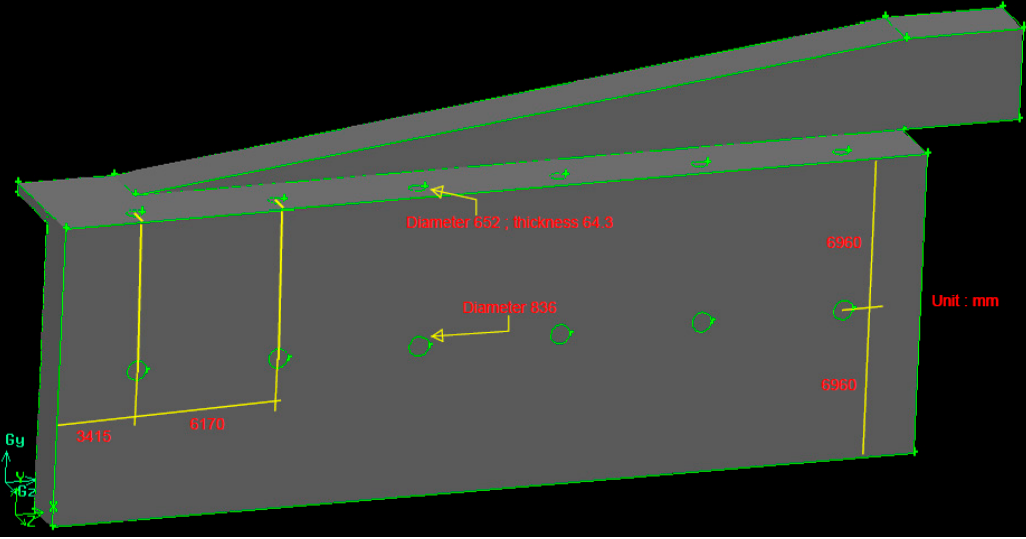
Figure 2. The arrangement of reforming tubes and burners as well as their dimensions for the simplified model.